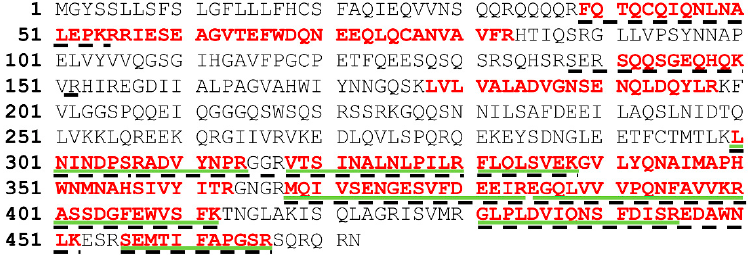
Figure 7. Amino acid sequence of the 11S globulin ( Pistacia vera ) (accession number: ABU42022). Positions of peptides identified by matrix-assisted laser desorption/ionization tandem mass spectrometry (MALDI-TOF/TOF) from lane ‘T’ in the Western blot are in red bold font. Positions of the peptides identified from the lane ‘4’ are underlined with green solid lines. Positions of the peptides identified from lanes ‘6’ and ‘8’ are discontinuous underlined.